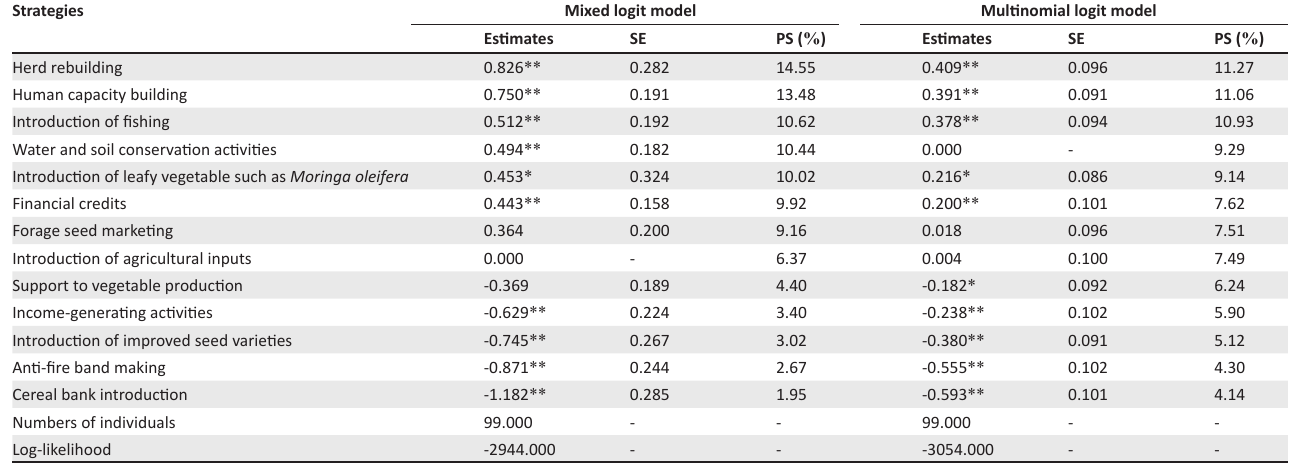
TABLE 2: Importance of newly introduced climate change adaptation strategies for farmers based on mixed logit and multinomial logit estimates.